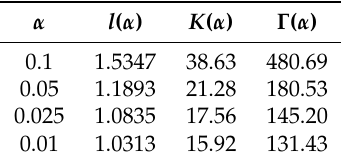
Table 1. Selected values for l , K and Γ functions in Theorem 1 for ε = 10 − 6